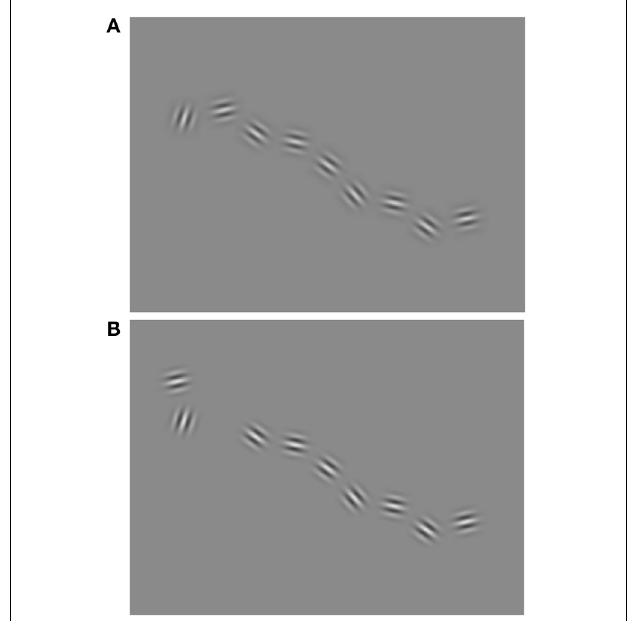
FIGURE 3 | Example of the visuospatial task with the original sequence of Gabor figures (A) and a sequence with a change in the location and orientation of one of the Gabor figures (B). Note that in the actual test, only a single Gabor was presented at a